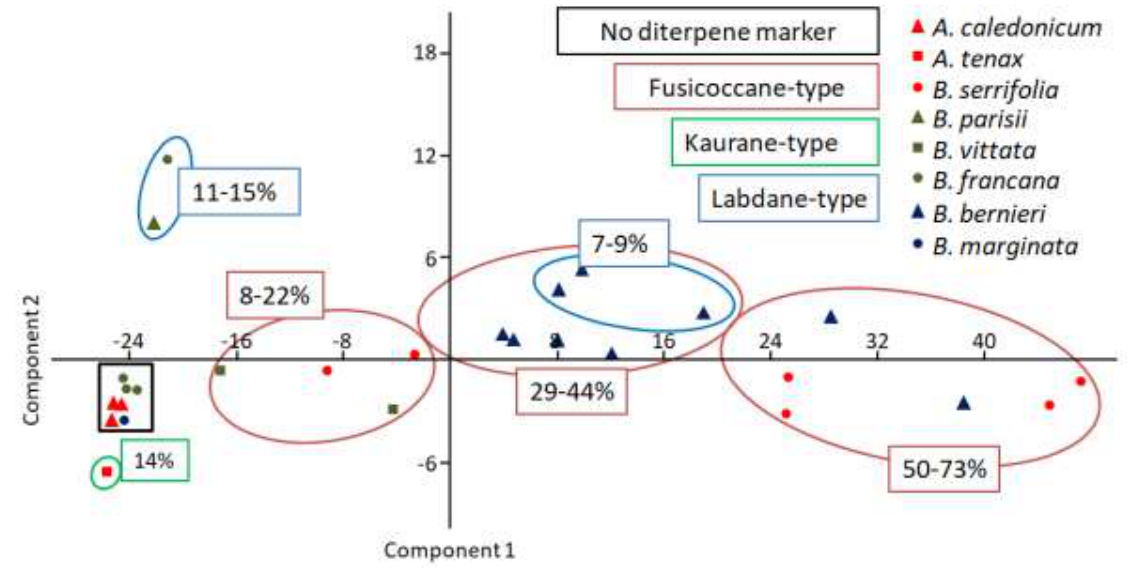
Figure 9. Principal Components Analysis (PCA) plot of diterpene types distribution of studied New-Caledonian Bazzanioideae species (PC1 = 96.4%; PC2 = 2.5%). New-Caledonian Bazzanioideae species (PC1 = 96.4%; PC2 =